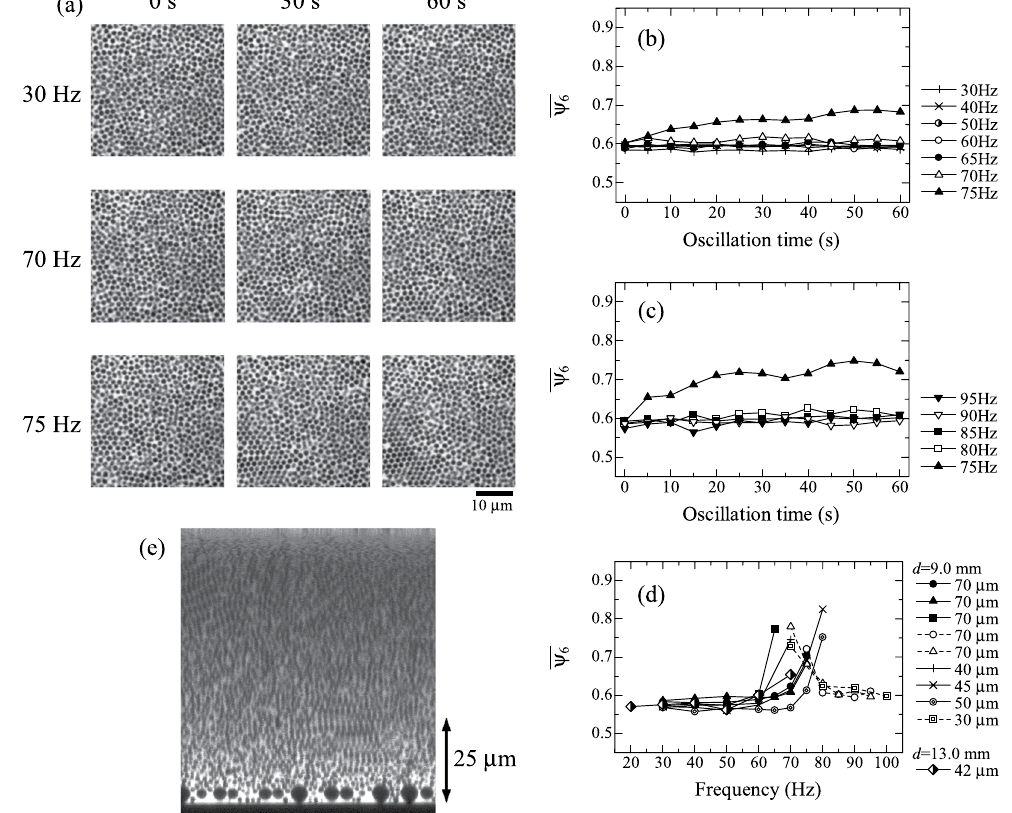
Figure 1. Crystallization of colloidal glasses under mechanical oscillations. ( a ) Microscopy images taken before and after 30 and 60 s oscillations are shown. They are parts of original images. ( b , c ) Evolution of the averaged bond orientational order parameter with increasing and decreasing the oscillation frequency. ( d ) Averaged bond orientational order parameter after oscillations for 60 s. ( e ) A cross-sectional image taken after 60-s oscillation at 75 Hz. The arrow indicates a typical height where 2D images are taken for